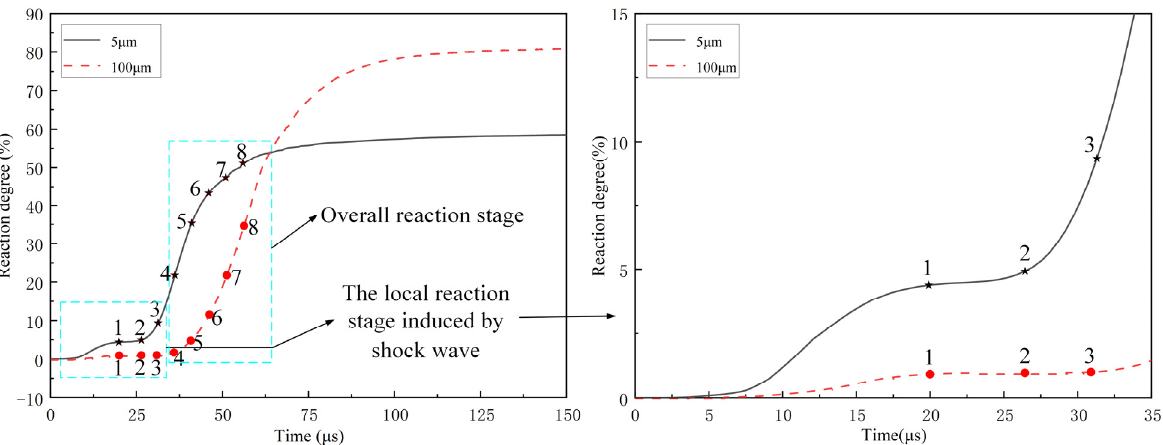
Figure 12. Reaction degree of reactive materials.